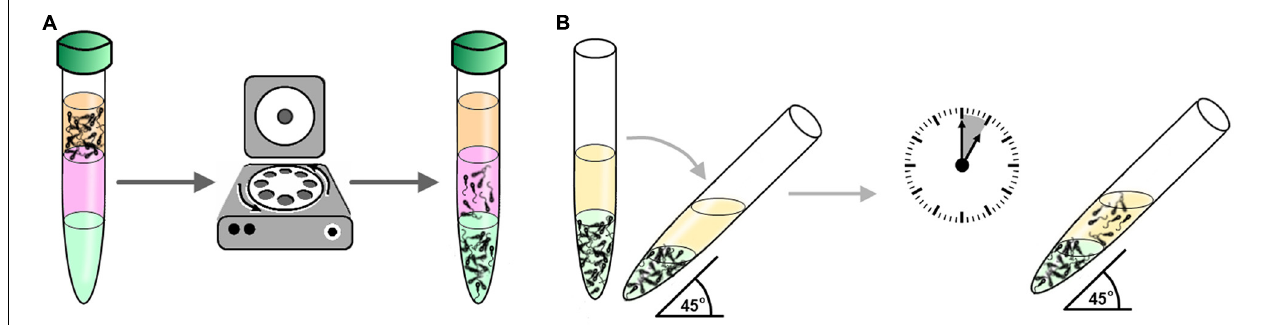
FIGURE 1 | Methods for routine sperm preparation for ARTs. (A) Example of sperm selection by density gradient centrifugation (DGC): Semen is placed on top a gradient of colloid (e.g., silica particles coated with silane) prepared in a centrifuge tube and then subject to centrifugation. Subsequently, motile spermatozoa are recovered from the tube bottom containing the fraction with higher density of colloid. (B) Example of sperm selection by swim-up (SU): In a centrifuge tube, a medium free of cells (yellow in the figure) is placed on top of the seminal sample (green in the figure). The tube is then inclined 45 ◦ and incubated for about 1 h allowing motile spermatozoa to swim-up towards the medium free of cells where they are collected for downstream